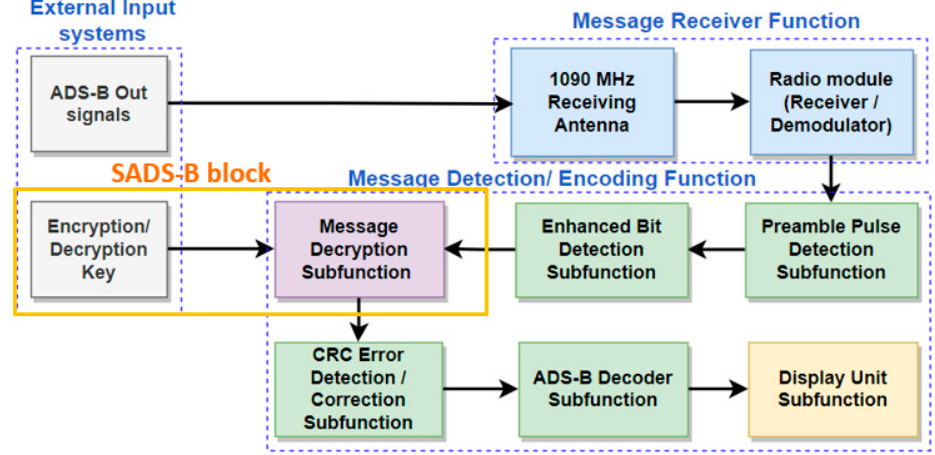
Figure 4. SADS-B In’s subfunction block diagram.